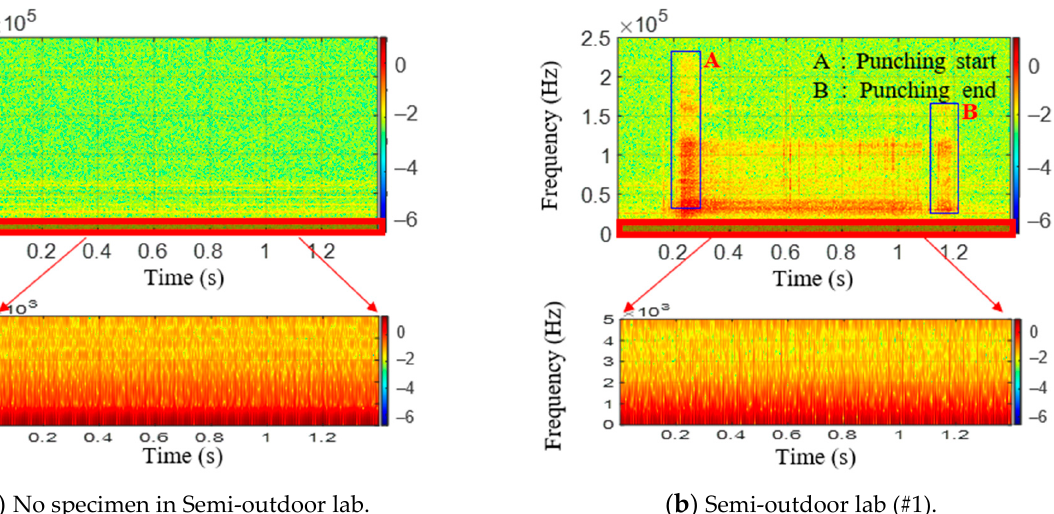
Figure 11. Result of fast Fourier transform applied to AE filtered signal.